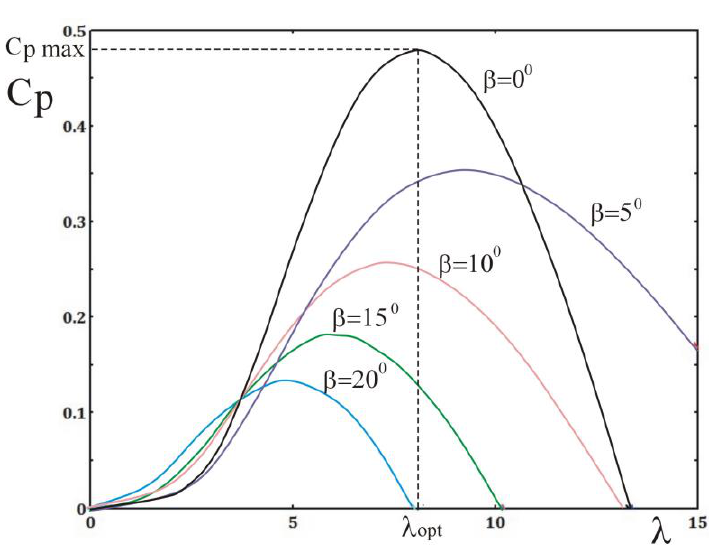
Figure 3. An example of the Cp( λ , β ) characteristics.